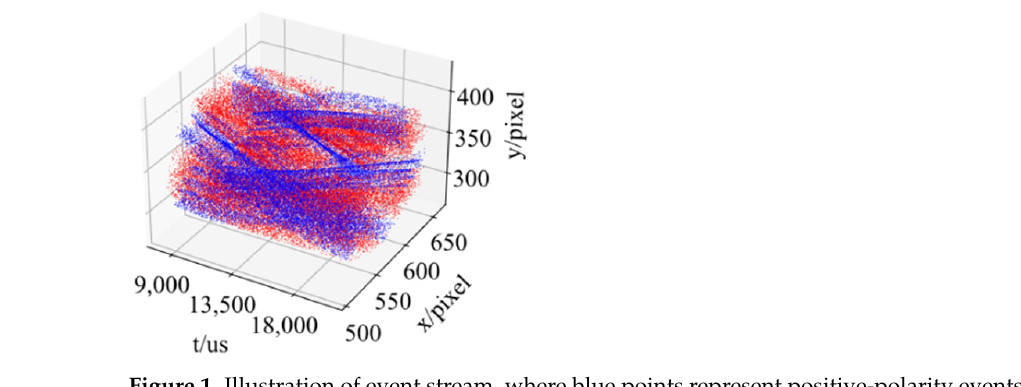
Figure 2. Visualization of event slices aggregated by different algorithms. ( A ) is accumulation ag- gregation; ( B ) is non-polarity aggregation; ( C ) is OR logic aggregation. Accumulation aggregation generates intensity images while OR logical aggregation results in binary images with much less noise than non-polarity aggregation.